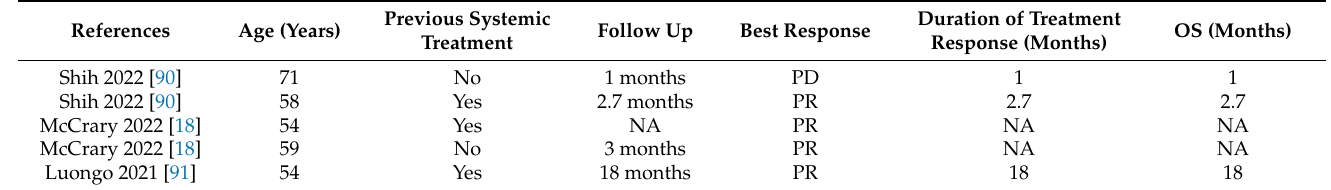
Table 4. Cases report of pembrolizumab and lenvatinib association in anaplastic thyroid cell